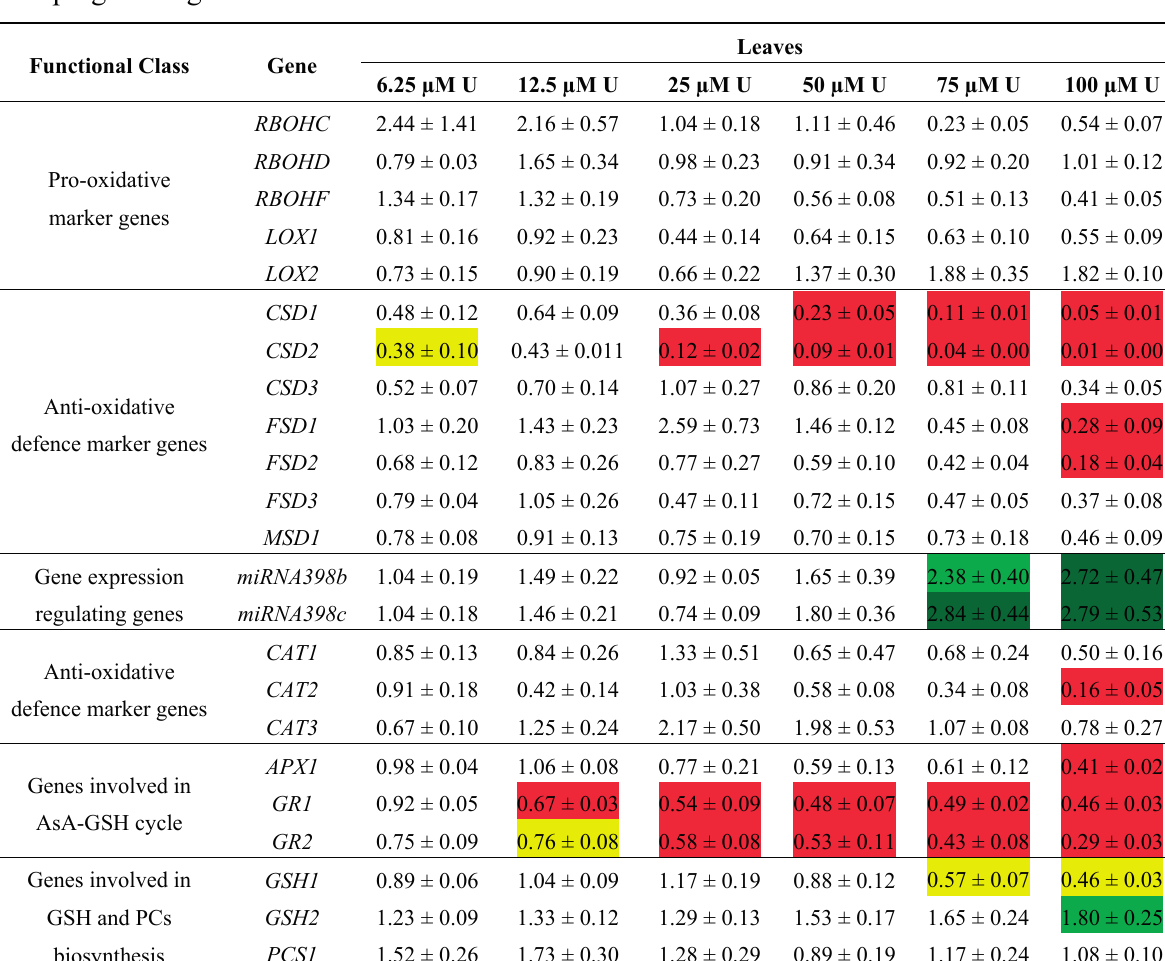
Table 3. Relative gene expression levels in Arabidopsis thaliana leaves of the genes involved in ROS production and scavenging after exposure to different U concentrations at pH